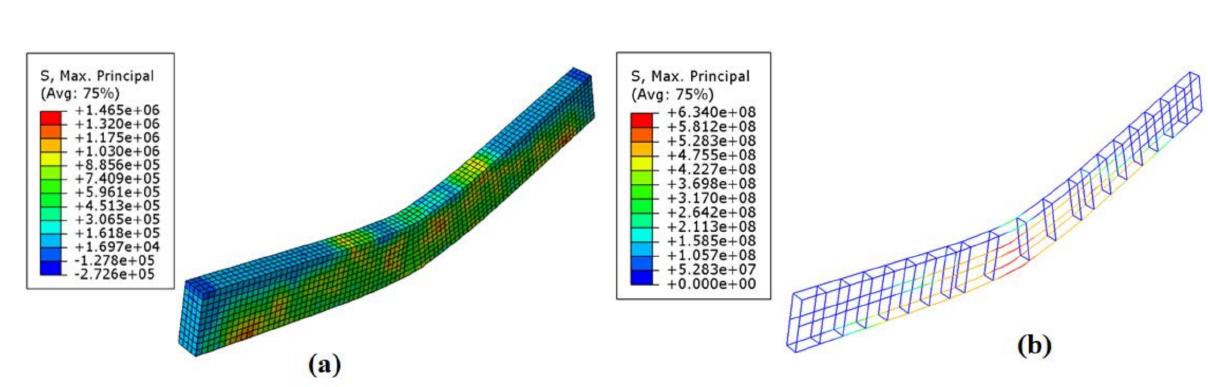
Figure 7. Max. principal stress (N/m 2 ) state of the simulation beam: ( a ) Concrete beam and ( b ) steel reinforcement.